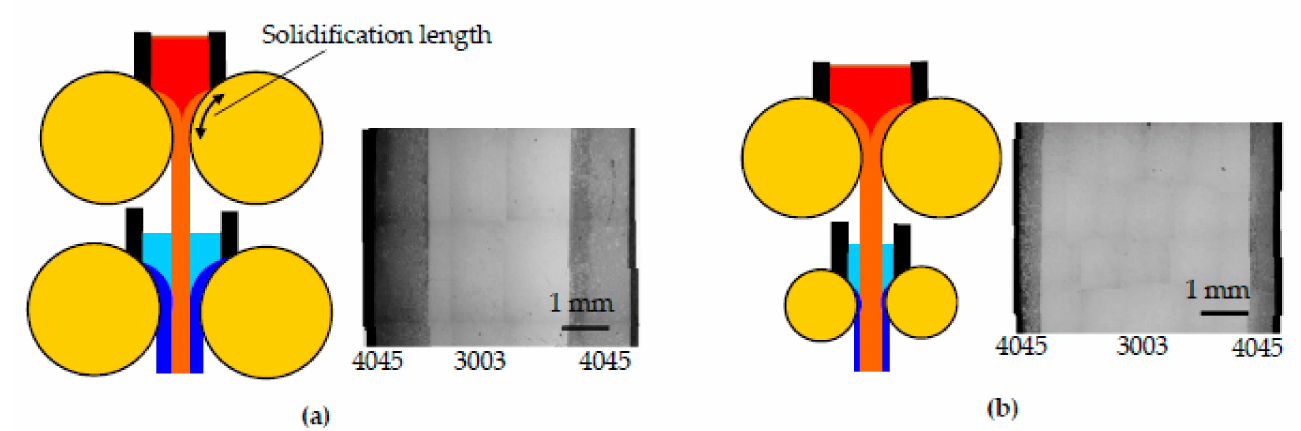
Figure 10. Control of strip thickness by solidification length and cross-section of as-cast clad strip. ( a ) The roll diameter of both the upper and lower twin roll casters was 200 mm. The solidification length of the base strip was 60 mm, and that of the overlay strip was 80 mm. ( b ) The roll diameters of the upper and lower twin roll casters were 300 mm and 100 mm, respectively. The solidification length of the base strip was 120 mm, and that of the overlay strip was 25 mm.